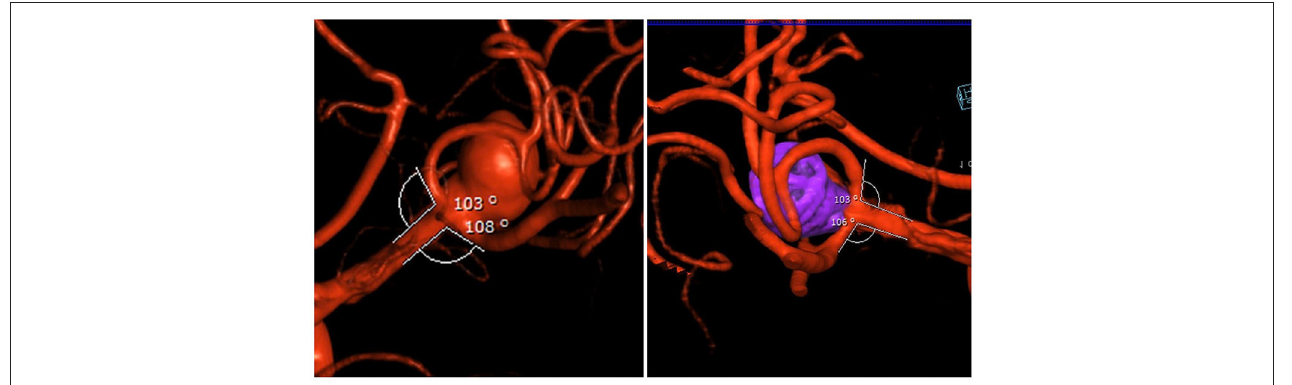
FIGURE 4 | (Left) pre-op bifurcation branch angles of the aneurysm. (Right) post-op: Raymond 1 occlusion and restoration of native bifurcation branch angles after removal of